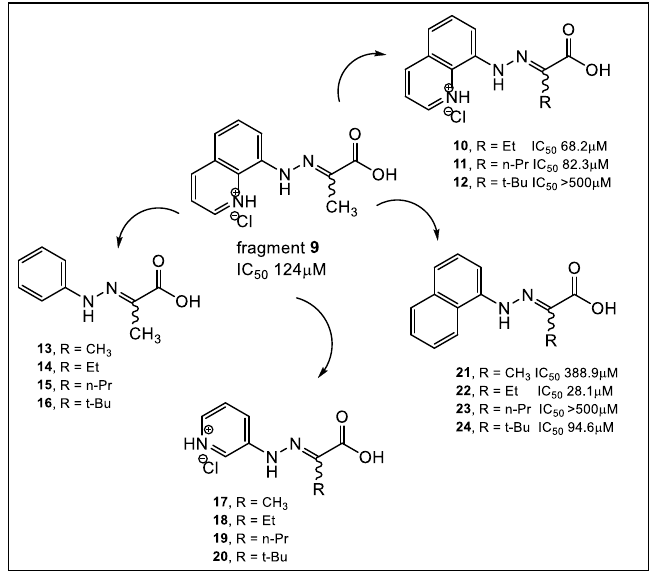
Figure 4. Fragments guide lead derivatization of fragment 9 as inhibitor of NDM-1 predicted by virtual screen of a library of 122,500 fragments. A combination of HTVS, SPR and NMR screening validated the synthesized derivatives of 9 ability to interact with NDM-1 [29].